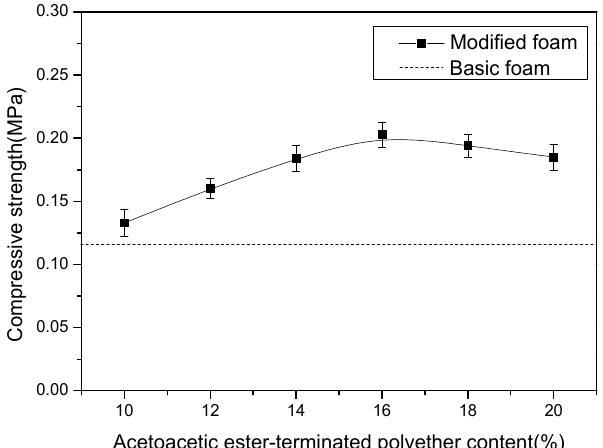
Figure 6. The effect of the acetoacetic ester-terminated polyether with different contents on the compressive strength of the foam.